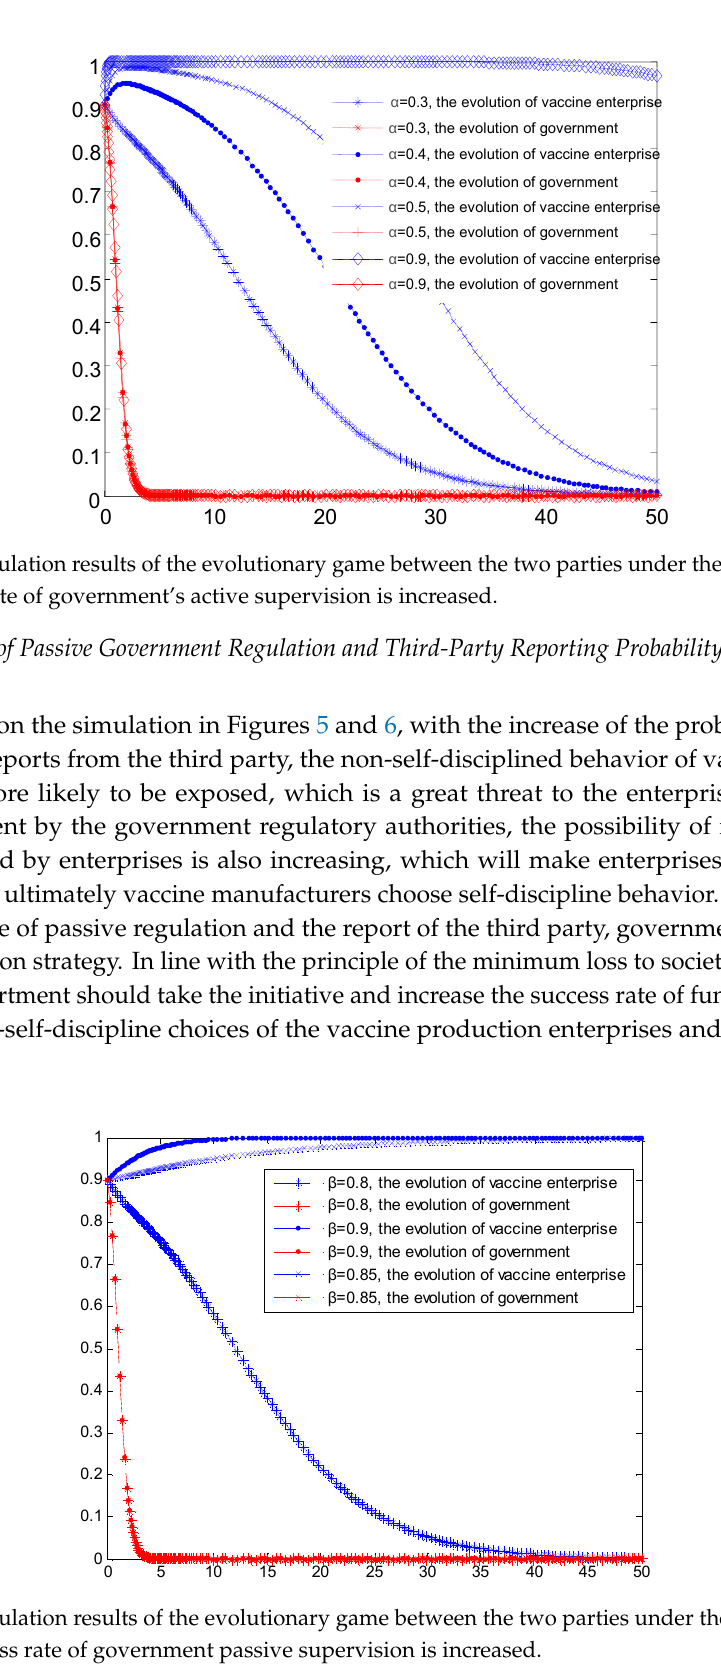
λ=0.4, the evolution of vaccine enterprise λ=0.4, the evolution of government λ=0.5, the evolution of vaccine enterprise λ=0.5, the evolution of government λ=0.8, the evolution of vaccine enterprise λ=0.8, the evolution of government